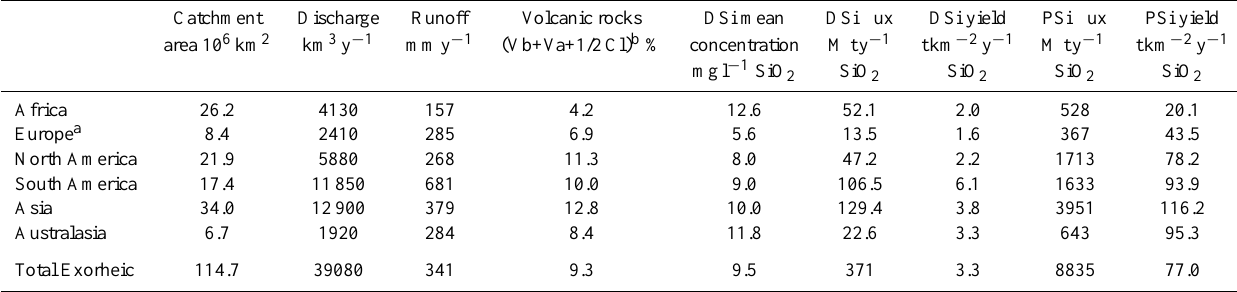
Table 1. Average dissolved and particulate silica fluxes, concentrations (runoff weighted averages) and yields (area weighted averages) for the exorheic parts of the continents. Catchment surface area, discharge and runoff are given as well as % of volcanic rocks from D¨urr et al. (2005). The fraction of PSi that possibly dissolves and becomes biologically available might be < 1% (see discussion). Catchment Runoff Volcanic